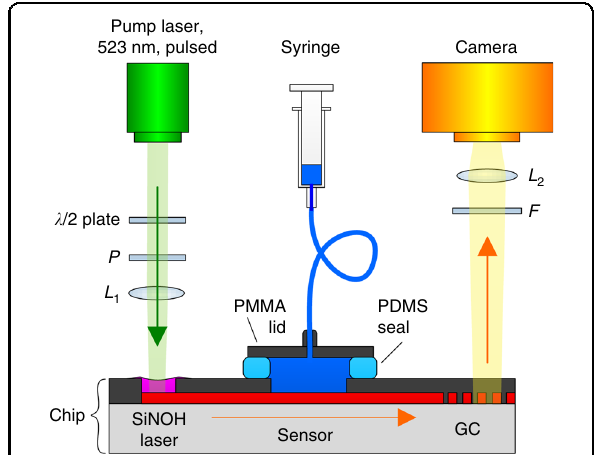
Fig. 5 Schematic of the experimental setup. The SiNOH laser is pumped with a free-space beam from a pulsed laser, which is focused by lens L 1 . The pulse energy is varied by rotating a half-wave ( λ /2) plate with respect to a fi xed linear polarizer P . The SiNOH laser is coupled to an on-chip WG (red) that guides the light to the interferometric sensor, please refer to Fig. 2a for a top view of the sensor chip. At the sensor output, light is radiated to an approximately surface-normal direction of the chip by a GC array. A long-pass fi lter F is used to suppress any stray light from the pump laser. A subsequent lens L 2 focuses the light on a CCD camera. The liquid analyte is pumped by a syringe through the fl uidic chamber that is formed by the chip surface and the PMMA lid with a PDMS seal in between. The volumetric fl ow rate is 0.6 mL s −